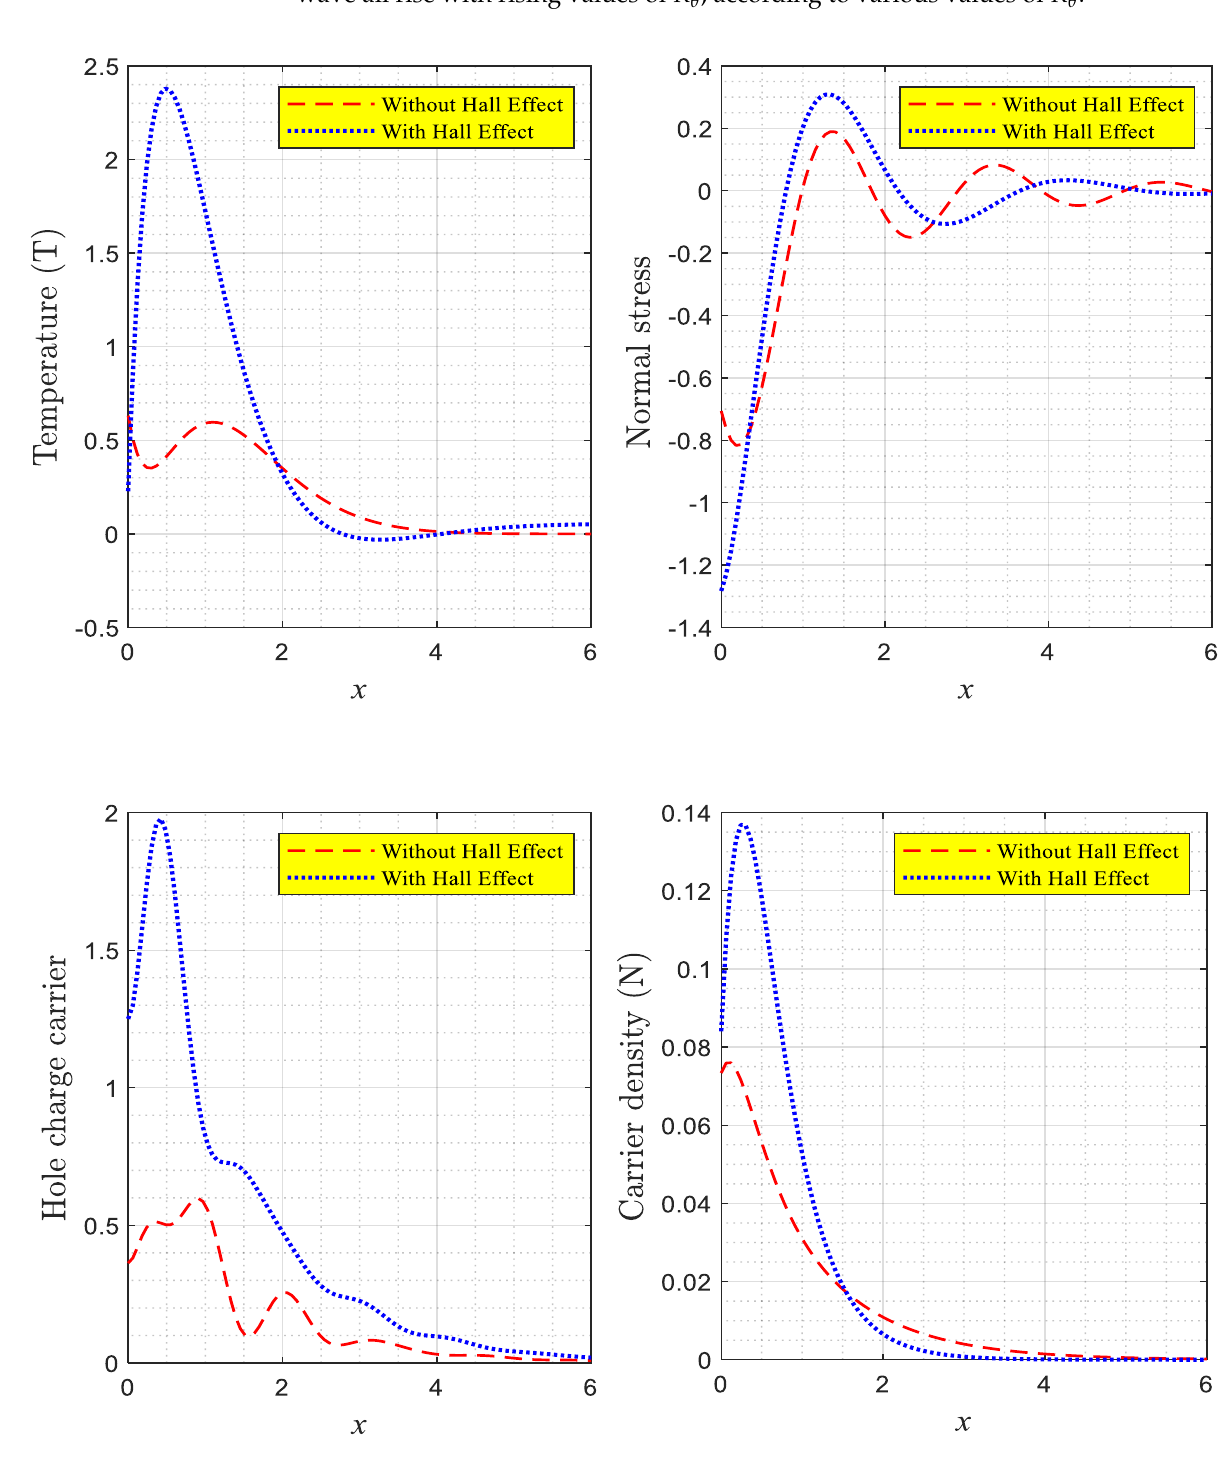
Figure 4. The DPL model’s change of non-local physical fields along with changing thermal conductivity in the absence and presence of Hall current.